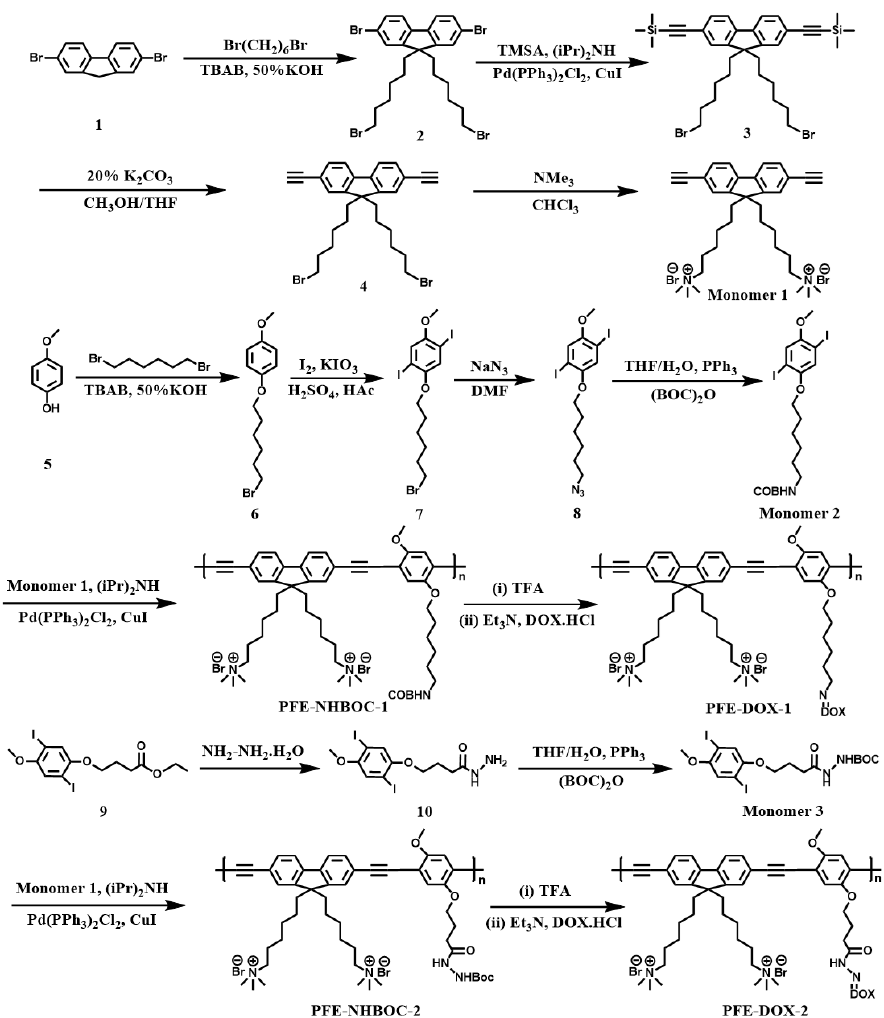
Figure 1. The synthetic routes of monomer 1, monomer 2, monomer 3, PFE-NHBOC-1, PFE- NHBOC-2, PFE-DOX-1 and